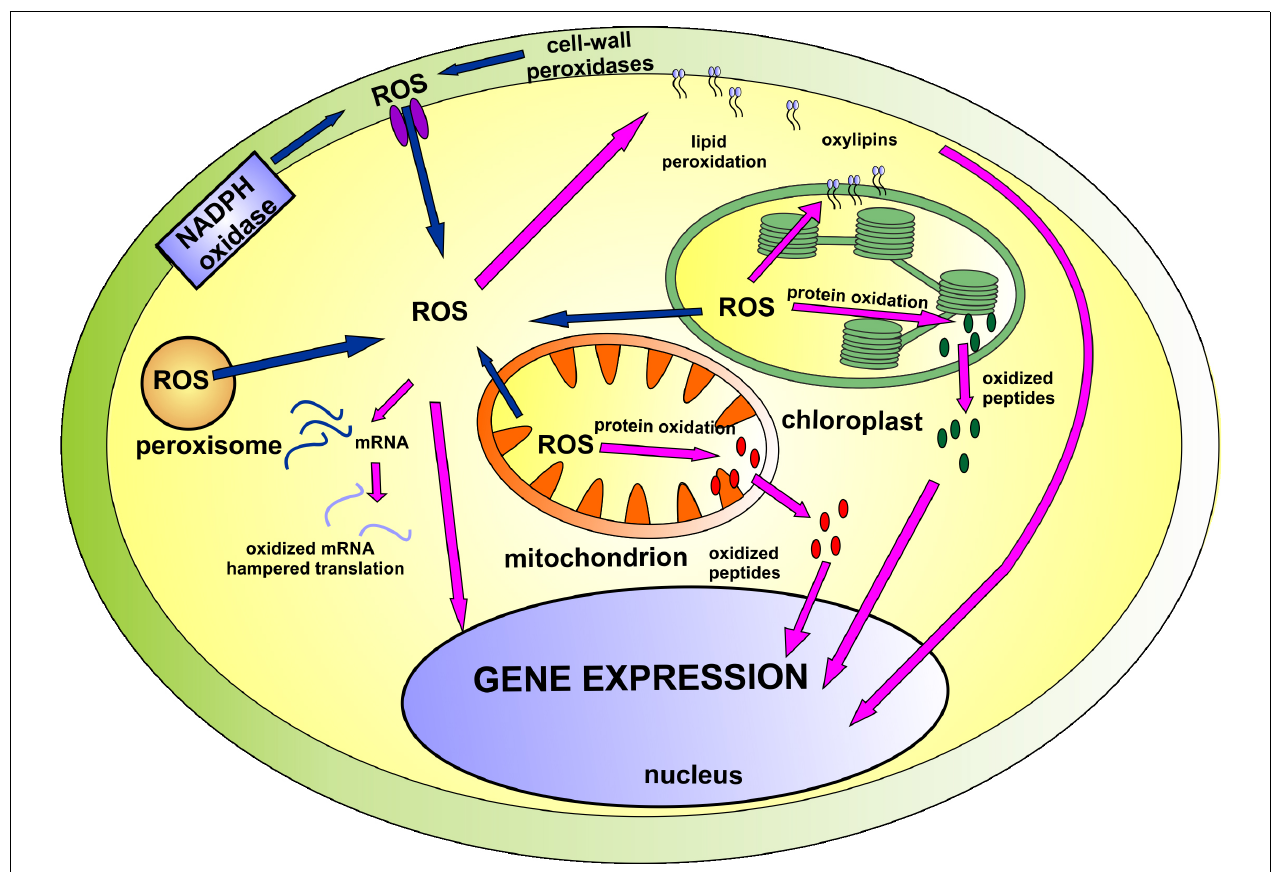
FIGURE 1 | The involvement of ROS and products of ROS-dependent oxidation in cellular signaling network. The main sources of ROS (marked with blue arrows) include mitochondria, chloroplast, NADPH oxidase and